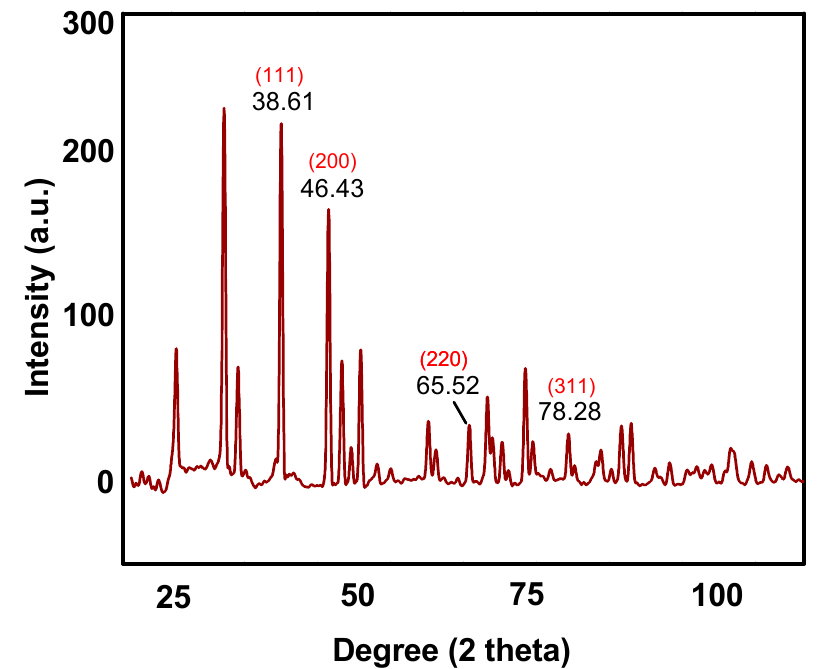
Figure 1. X-ray diffraction pattern of as-prepared